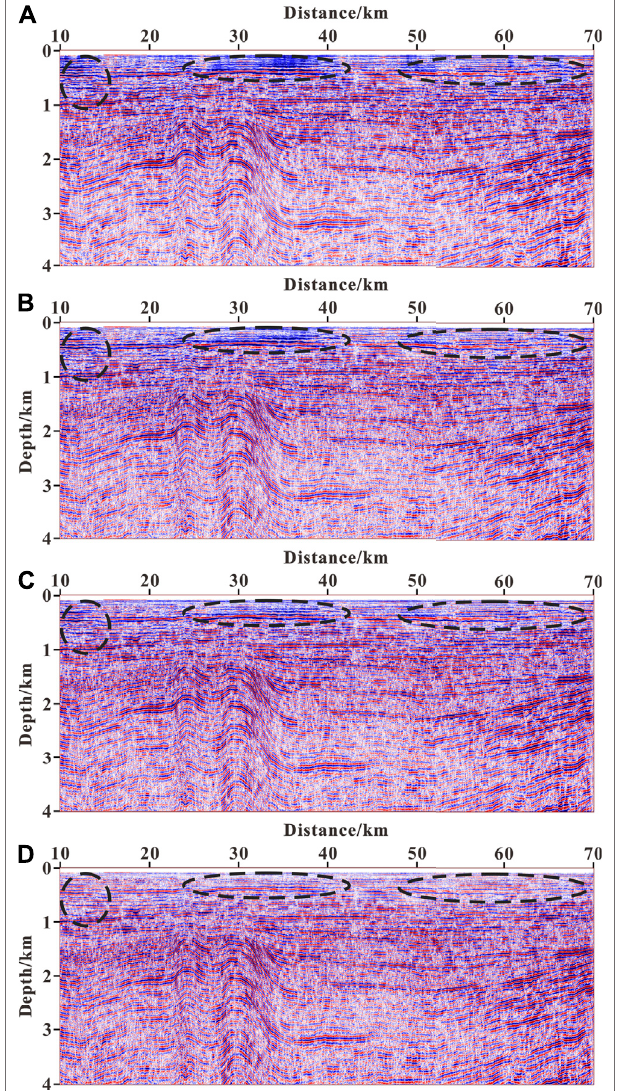
FIGURE12| RTMsection for fi eldmarine seismic data: (A) conventional RTM; (B) RTM with wave fi eld decomposition based on the Poynting vector; (C) RTM with wave fi eld decomposition based on the optical fl ow vector; (D) angle-weighted RTMwithwave fi elddecompositionbasedontheoptical fl ow